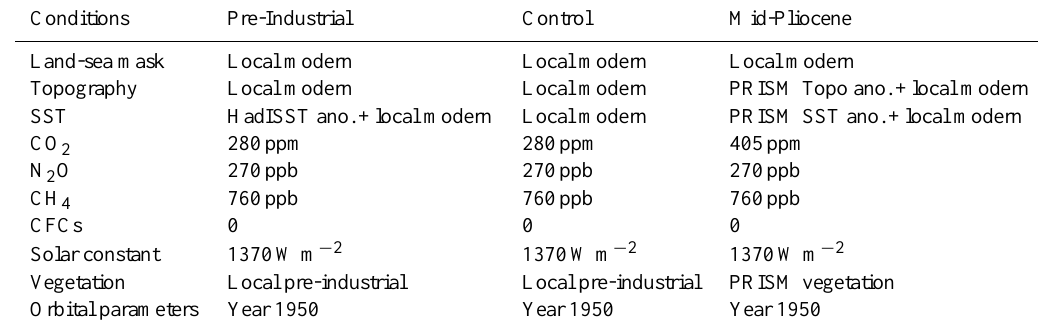
Table 1. Boundary conditions for the pre-industrial, the control and the mid-Pliocene experiment. Conditions Pre-Industrial Control Mid-Pliocene Land-sea mask Local modern Local modern Local modern Topography Local modern Local modern PRISM Topo ano.+local modern SST HadISST ano.+local modern Local modern PRISM SST ano.+local modern CO 2 280ppm 280ppm 405ppm N 2 O 270ppb 270ppb 270ppb